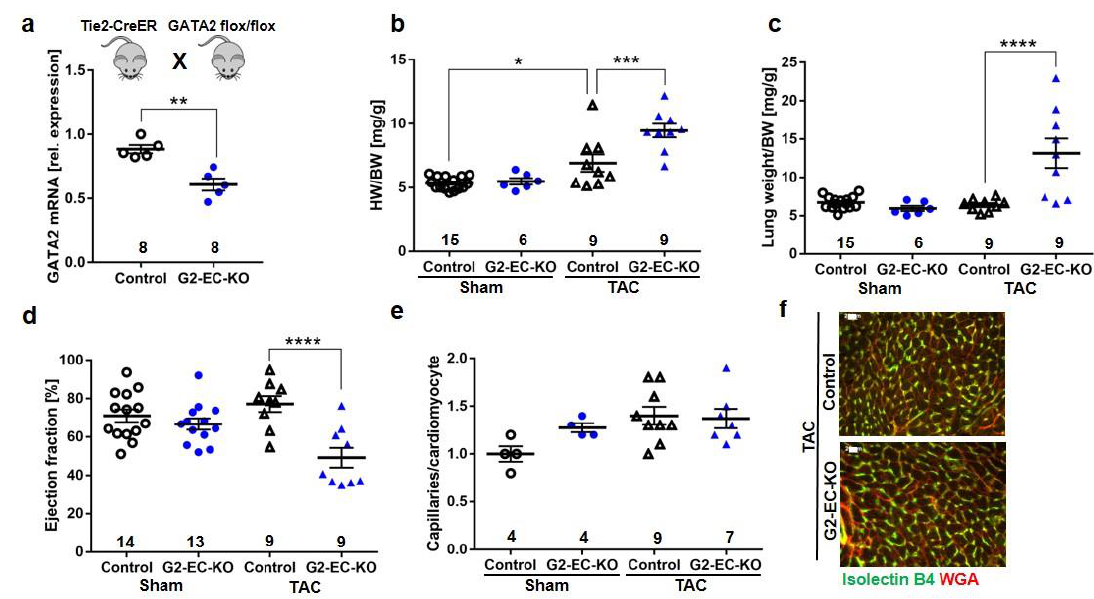
Figure 2. Endothelial GATA2 knock-out mice (Tie2-Cre-G2-EC-KO) develop heart failure during pressure overload (TAC). ( a ) qPCR of GATA2 mRNA in cardiac endothelial cells (EC) from indicated mice. ( b ) Heart weight/body weight (HW/BW), ( c ) lung weight/BW ratio, and ( d ) left ventricular ejection fraction (EF) 2 weeks after sham or TAC surgery. ( e ) Capillaries/cardiomyocyte ratio and ( f ) representative immunofluorescence pictures (scale bar, 20 µm). Data are mean ± sem; the number of biological replicates is shown in the graphs; * p < 0.05, ** p < 0.01, *** p < 0.001, **** p < 0.0001.